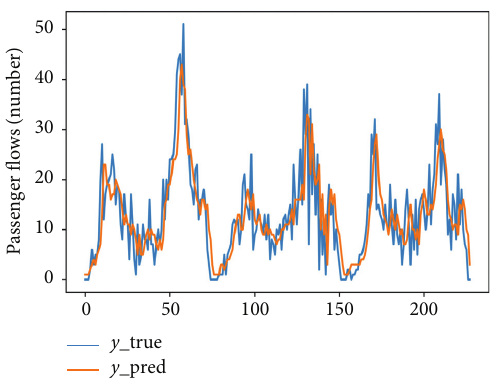
Figure 11: Regression integration prediction results when the time step is 2h.